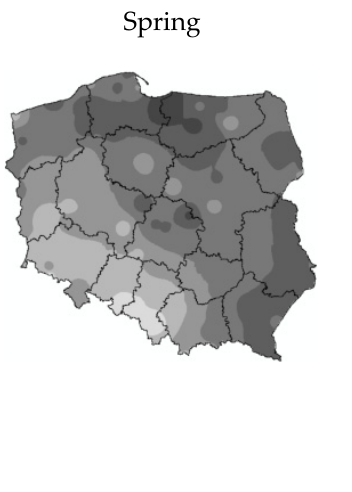
Figure 6. Frequency of three types of meteorological drought (moderate, severe and extreme), determined on the basis of the SPI-3 index in spring, summer and autumn. Years 1951–2020. In the spring season, SPI-3 displays a significant (at a level of α < 0.1) negative trend in 1951–2020, which means that year-by-year MDr will intensify, mainly in southwest Poland (Figure 7).